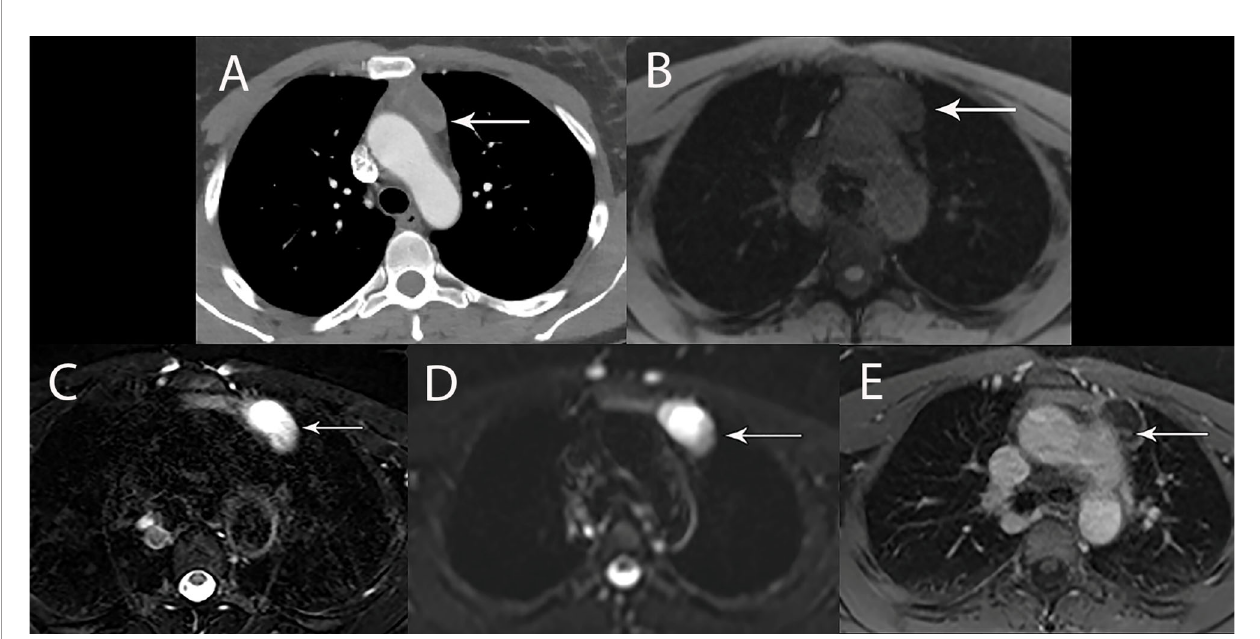
FIGURE 5 | 44 year old woman with cystic thymoma. (A) Contrast enhanced CT shows solid component along the posterior aspect. MRI showed intermediate signal intensity on T1 weighted (B) , high signal intensity on T2 weighted images (C) and DWI (D) consistent with cystic component. The small solid component (arrow) shows enhancement on post contrast T1 weighted images (E)